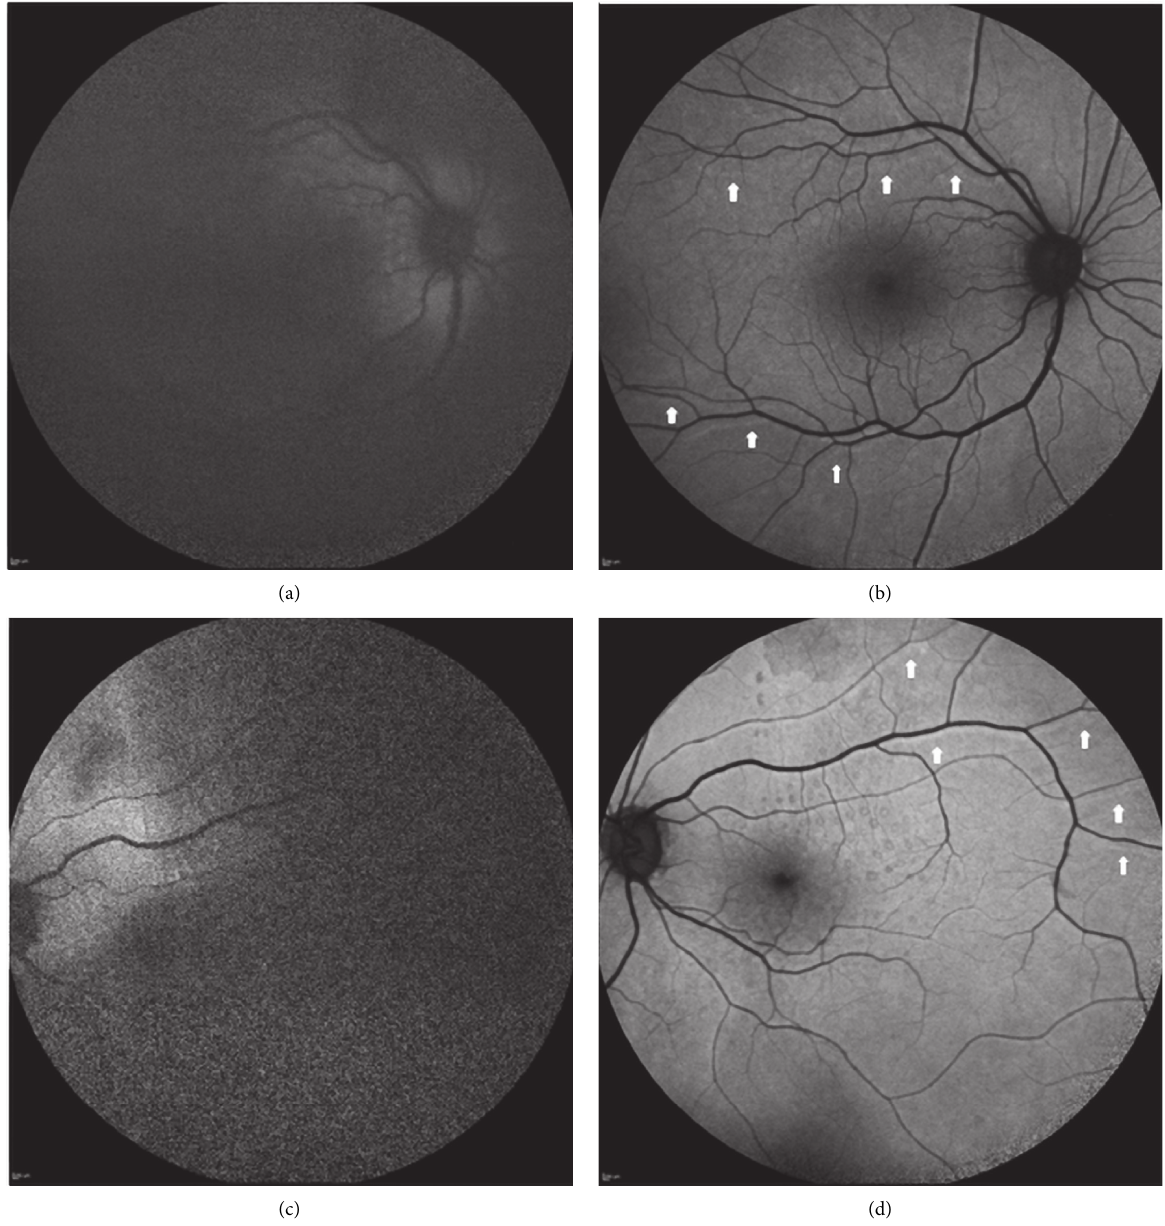
Figure 1: Unintentional displacement of the retina observed on blue-fundus autofluorescence (B-FAF) imaging 1 month after repair of fovea-off rhegmatogenous retinal detachment with PPV and 1000-centistoke silicone oil (SO) tamponade. Both eyes presented with preoperative proliferative vitreoretinopathy grade B received perfluorocarbon liquid intraoperatively, and a fluid-air exchange before injection of SO. Detachment involved 4 quadrants (with the breaks located in the upper and lower quadrants) in the case shown in (a) (the right eye of a 64-year-old lady) and 3 quadrants (with the breaks located in the upper quadrants) in the case shown in (c) (the left eye of a 74- year-old man). After retinal reattachment (b, d), retinal vessel printings (arrows) in the form of lines of increased autofluorescence running inferiorly to the corresponding retinal vessels were visible and indicated an upward displacement of the retina in both